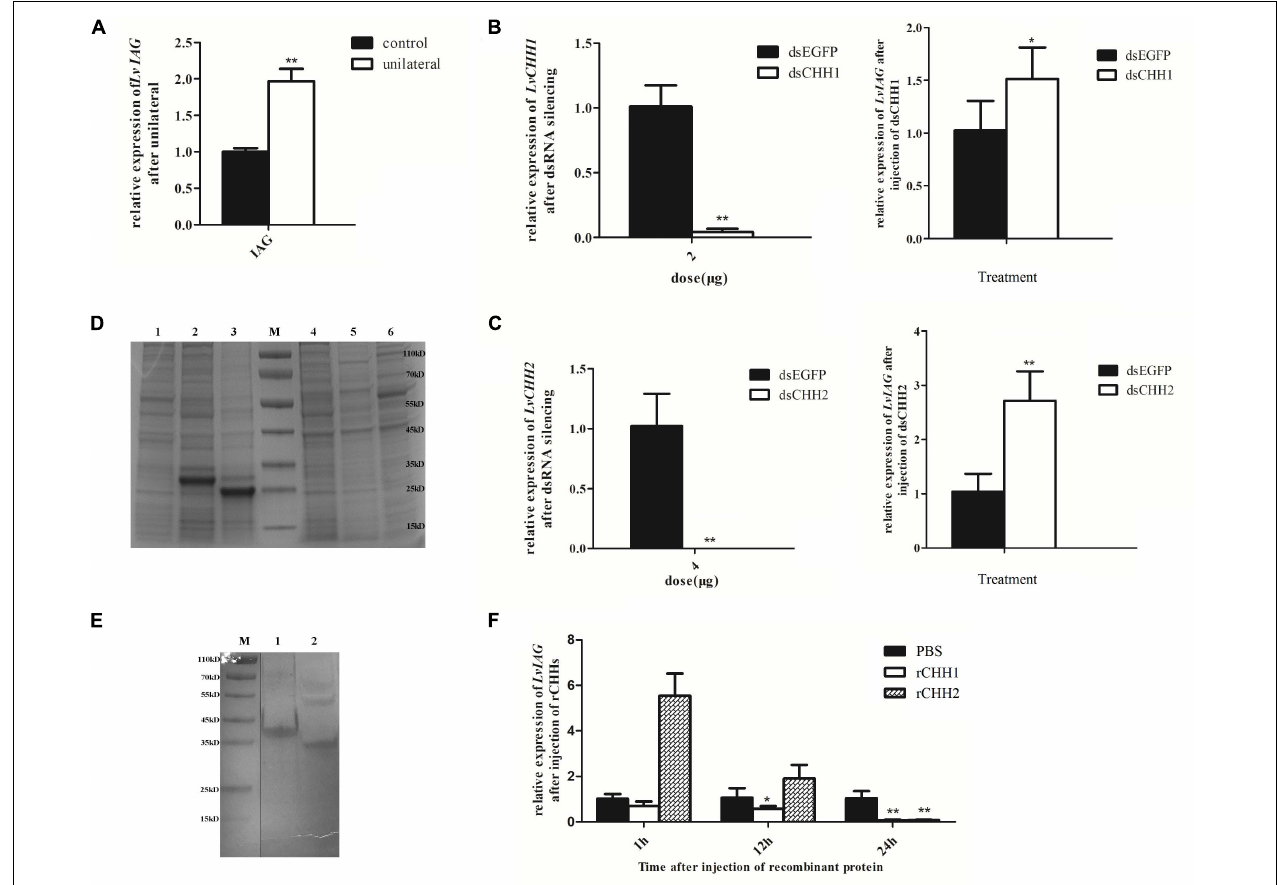
FIGURE 7 | The inhibitory effects of LvCHH1 and LvCHH2 on the expression of LvIAG . (A) Expression level of LvIAG after unilateral eyestalk ablation. (B) Expression levels of LvIAG after LvCHH1 knockdown. (C) Expression levels of LvIAG after LvCHH2 knockdown. dsEGFP, injected with dsEGFP; dsCHH1, injected with dsCHH1; dsCHH2, injected with dsCHH2. (D) The recombination proteins of LvCHHs. 1–3, inclusion body; 1, pET30a; 2, rCHH1; 3, rCHH2; 4–6, supernatant; 4, pET30a; 5, rCHH1; 6, rCHH2; M, protein ladder. (E) The recombination proteins of LvCHHs after purification and refolding. 1, rCHH1; 2, rCHH2; M, protein ladder. (F) Expression levels of LvIAG after injection with rCHH1 and rCHH2. PBS, injected with PBS; rCHH1, injected with rCHH1; rCHH2, injected with rCHH2. Expression levels of target genes were detected in three replicates. Significant differences of the gene expression levels between two treatments were shown with a star ( ∗ ) at P < 0.05 or two stars ( ∗∗ ) at P <